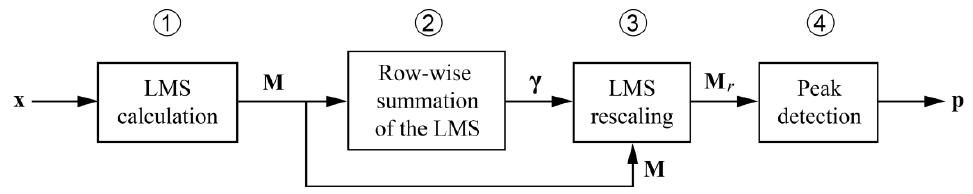
Figure 1. Calculation steps of the AMPD algorithm.